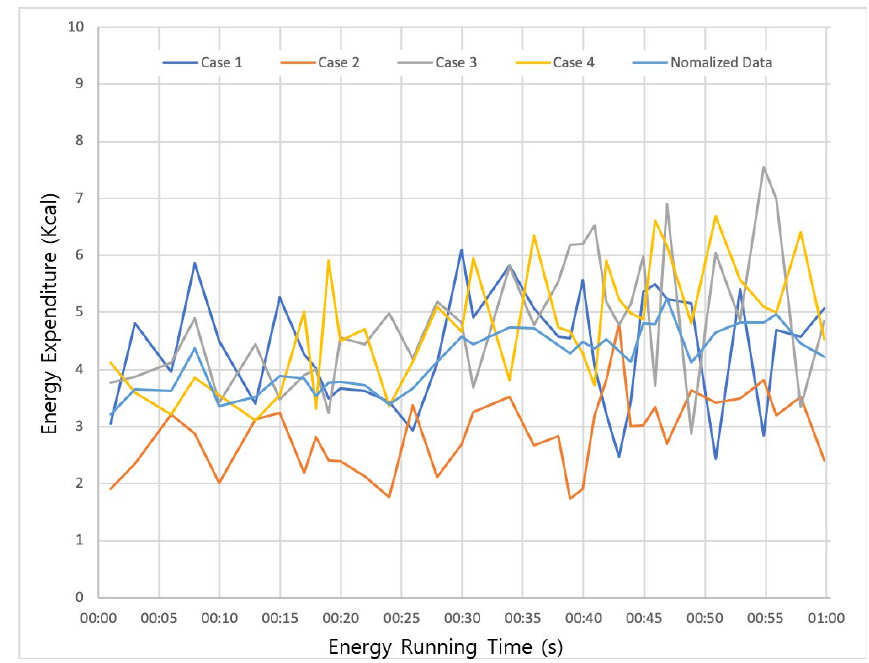
Figure 7. Approximation of EE (kcal) for general physical activity/exercise conditions.